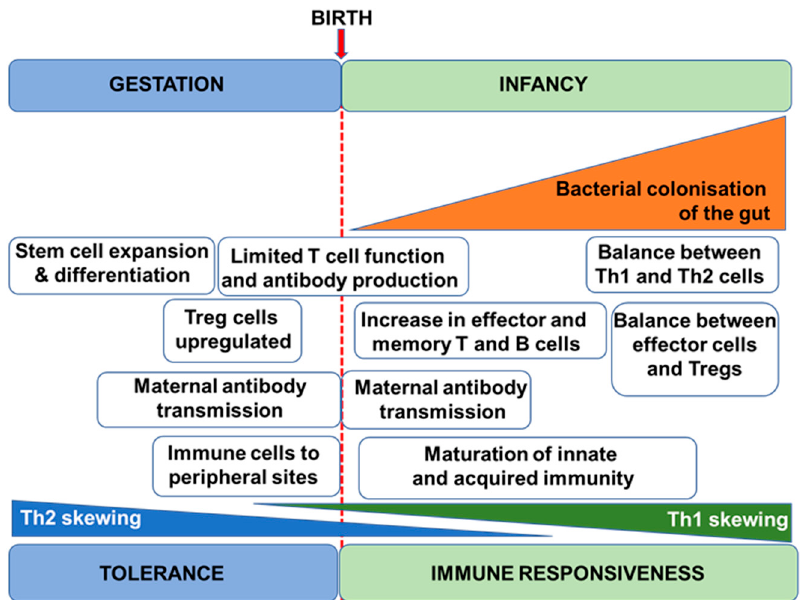
Figure 1. Schematic depiction of the early development of the human immune system. Treg, regu- latory T cell.